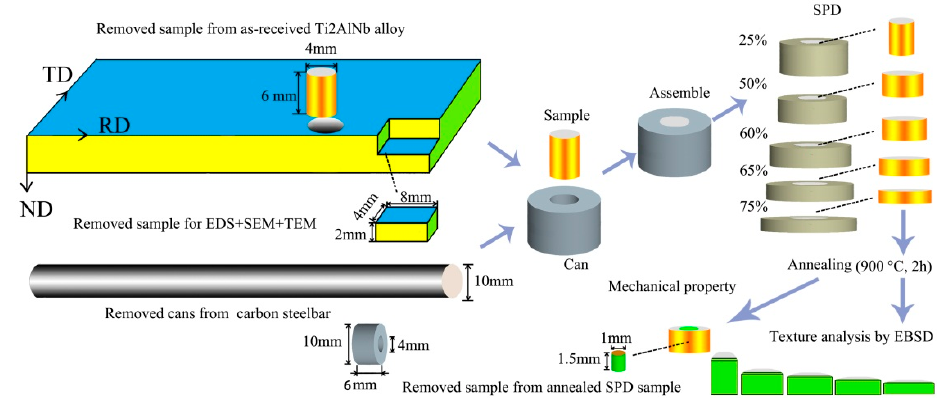
Figure 1. Schematic diagram of the experimental procedure. SPD—severe plastic deformation. (RD, rolling direction; TD, transverse direction; ND, normal direction).